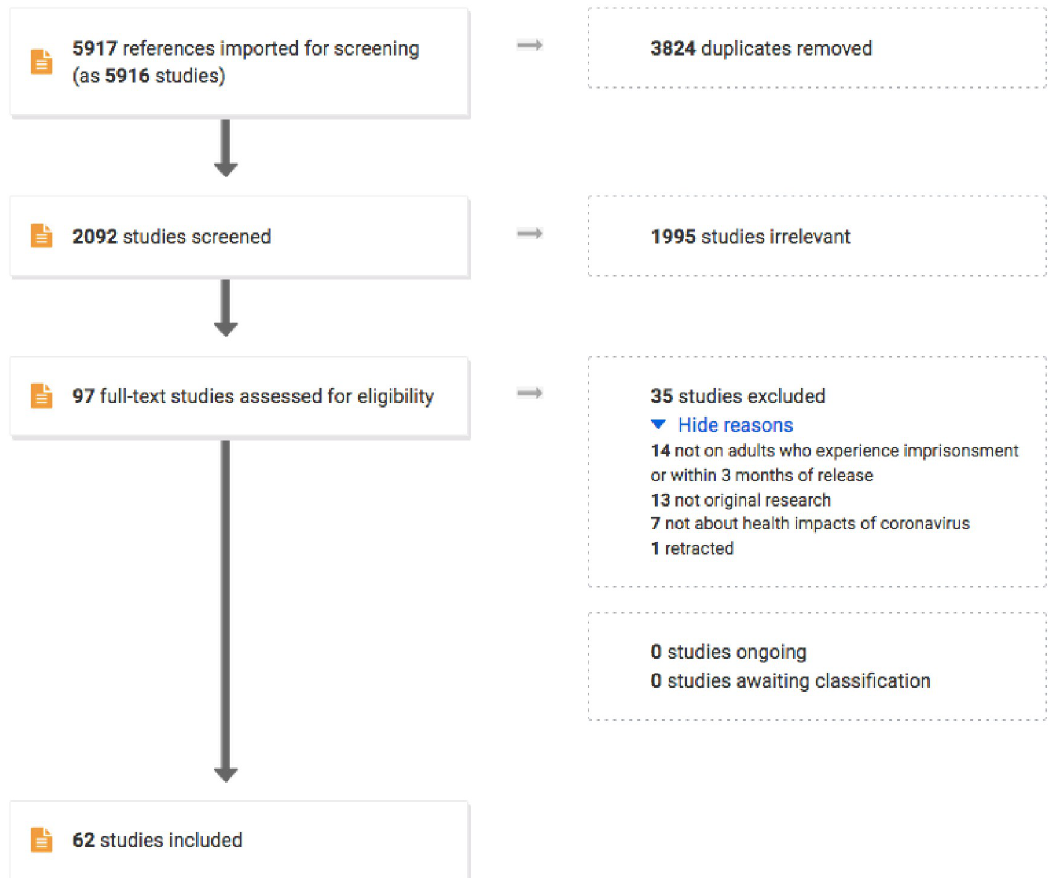
Fig 1. Flow diagram for studies included in a systematic review on the health impacts of the COVID-19 pandemic on people who experience imprisonment.